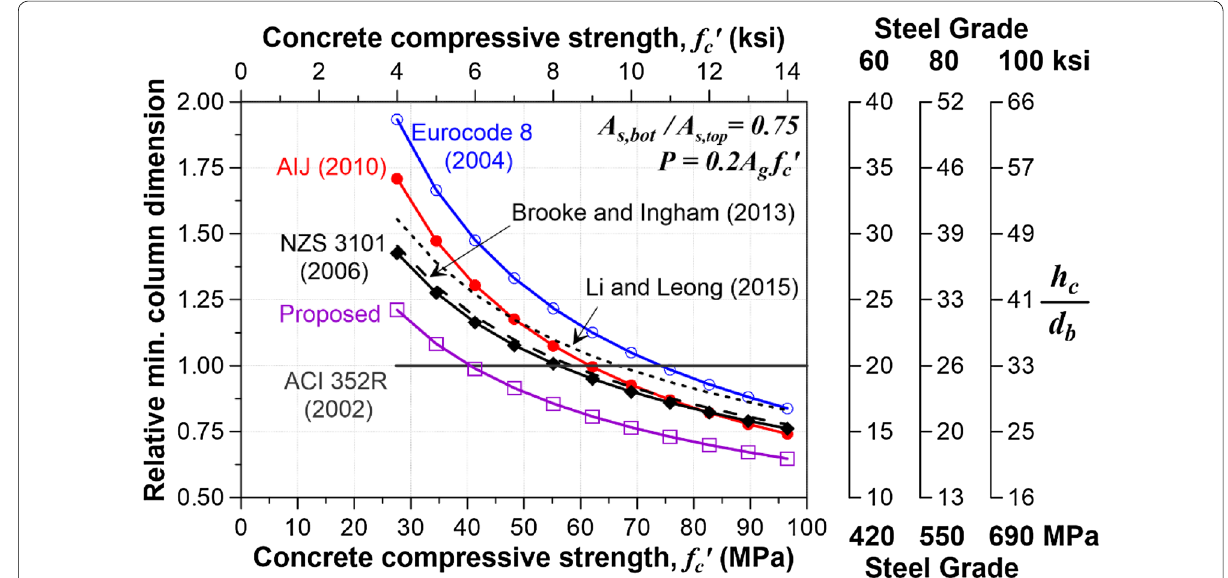
Fig. 3 Comparison of minimum column dimensions required by different codes and recommendations for a reference beam‑column joint having a column axial load of 0.2 A g f ′ c , a reinforcement ratio of A s , bot / A s , top = 0.75 , and various concrete